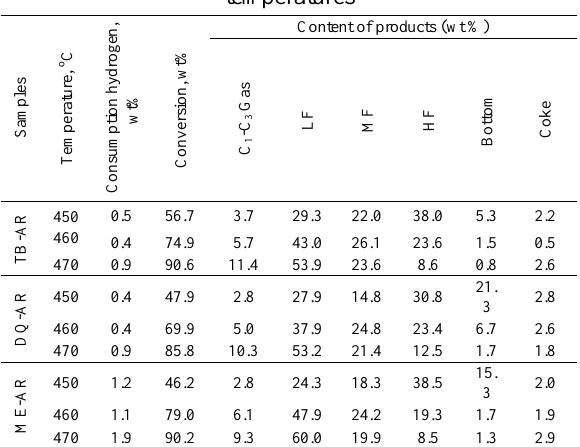
Table 3. The products content after catalytic hydrocracking of the atmospheric residue at different temperatures